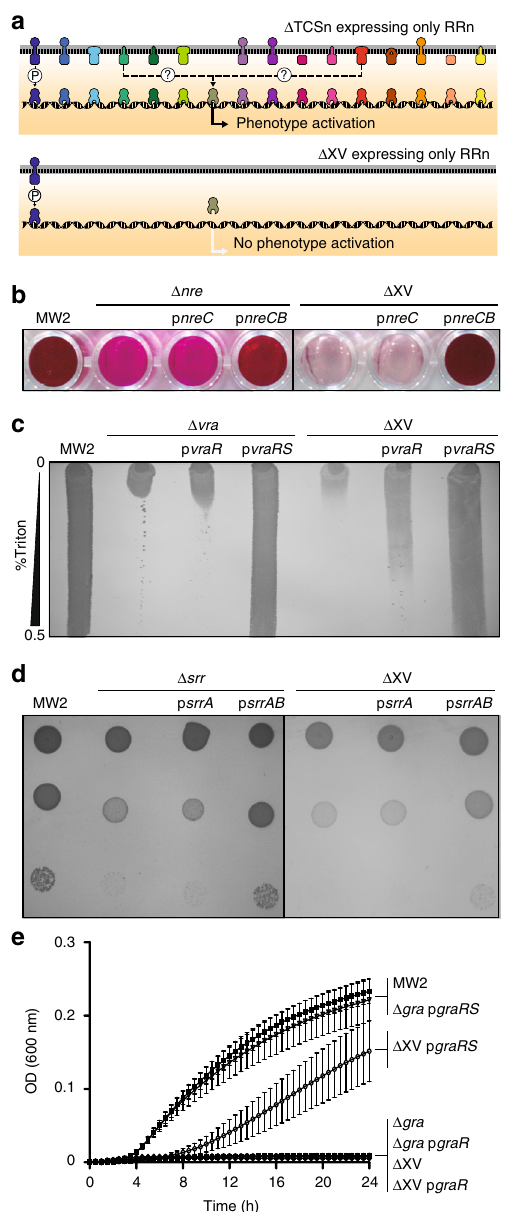
Fig. 5 Analysis of TCS cross-activation in vivo. a Scheme of the followed strategy. Ectopic expression of a RR in the corresponding single TCS mutant and in Δ XV strain. A phenotype rescue in the single TCS mutant, but not in Δ XV strain, might indicate the cross-activation from non-cognate sensor kinases. This strategy was used to analyze the cross-activation of the corresponding phenotypes. b Nitrate reduction capacity. Nitrite presence was colorimetrically detected. c Growth capacity on Triton X-100 concentration gradient agar plates. d Bacterial growth on TSA medium at 28 °C. Serial dilutions were spotted on agar plates. e Growth curves in TSB medium at pH 4.5. Average and SD of three independent assays were recorded. Complementation with the complete TCS was used as a control in all